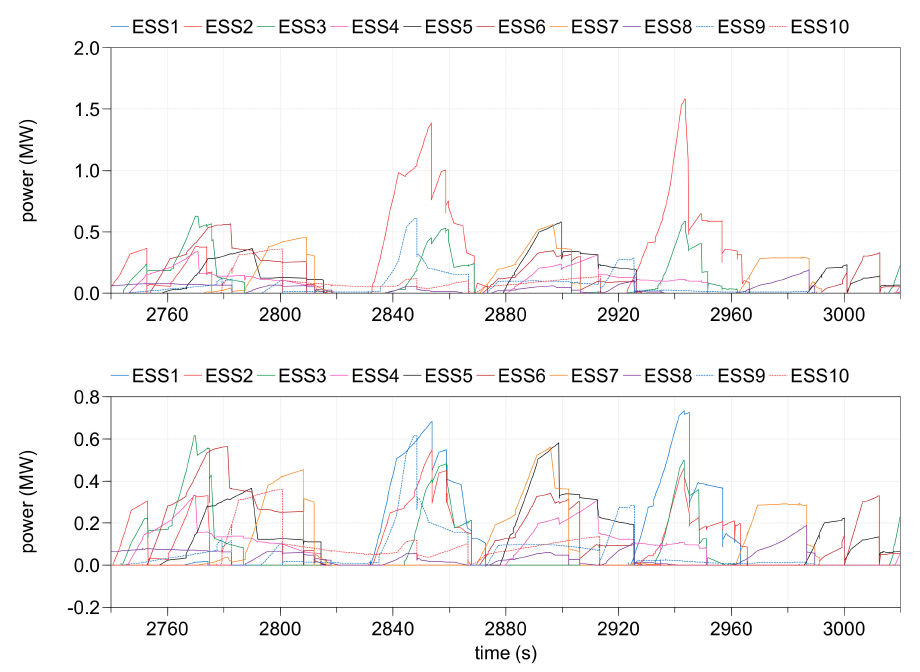
Figure 6. Power delivered from ESSs, in the case of failure from ESS1 (top) or no failure